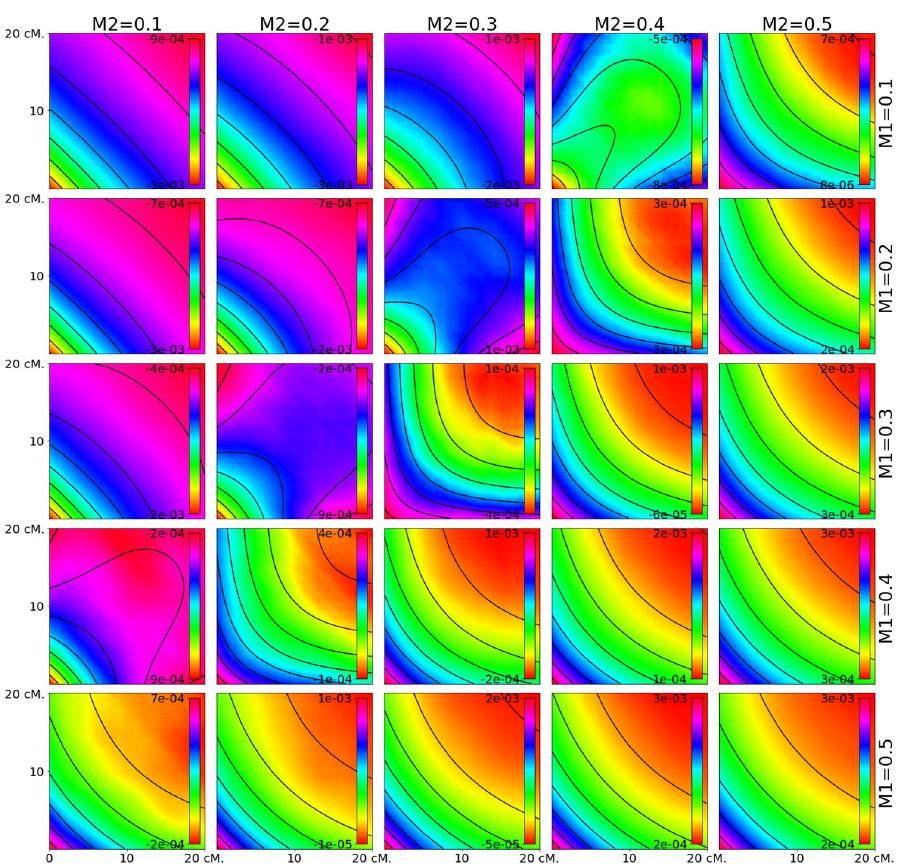
Fig 2. Predicted weighted LD surfaces from simulations and theory for varying admixture proportions. The heat maps are from simulations and the contours are plotted from Eq 7. The two admixture times were fixed at 2 and 12 generations ago ( T 1 = 10 and T 2 = 2) while the admixture probabilities were varied. Each square covers the range 0.5 cM < d , d 0 < 20 cM. As the total admixture proportion m 2 + m 1 (1 − m 2 ) increases above 0.5, the contours change to reflecting that the majority contribution of the genetic material now originates from the other population. Weighted LD surfaces for m 1 > 0.5 or m 2 > 0.5 are not shown, but are qualitatively similar to the surfaces on the lower and rightmost